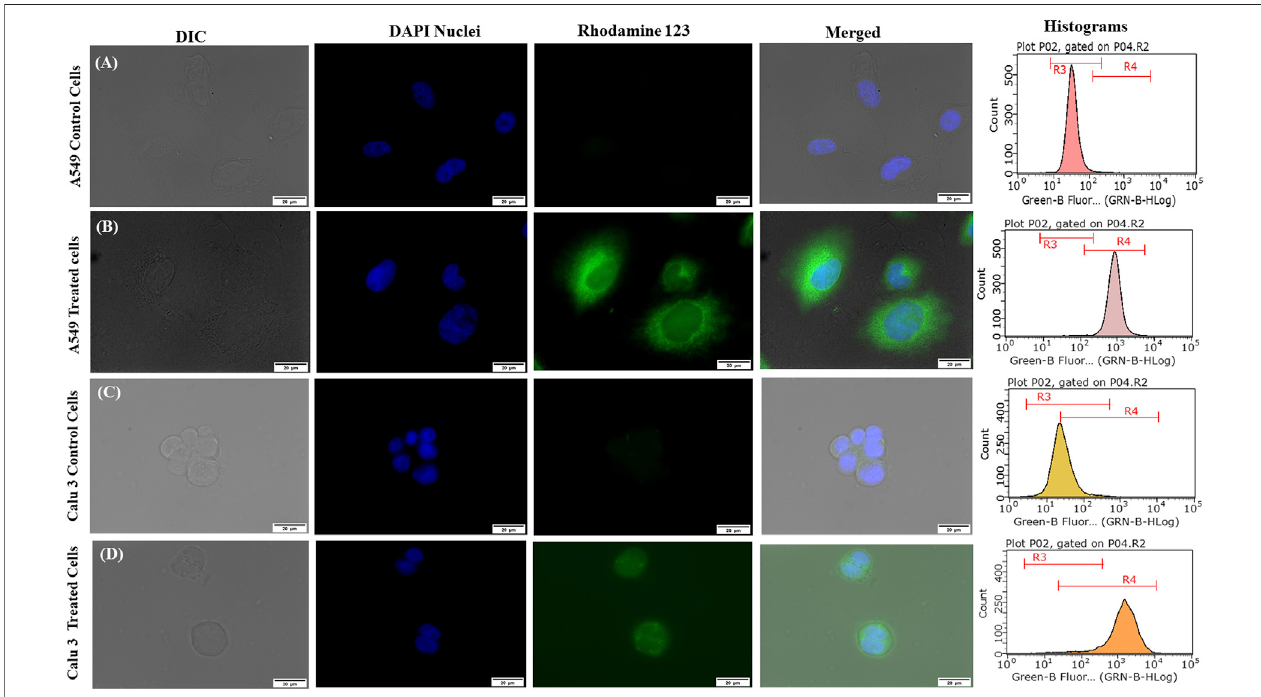
FIGURE 7 | Fluorescent microscopic images and histograms of Rhodamine 123-loaded lipid nanovesicles (LNVs) with green (Rhodamine 123) and blue (DAPI) fl uorescence in (A) A549 control cells (B) A549-treated cells, (C) Calu 3 control cells, (D) Calu 3-treated cells.